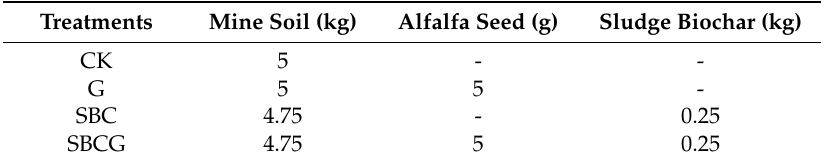
Table 2. Four treatments were designed in this